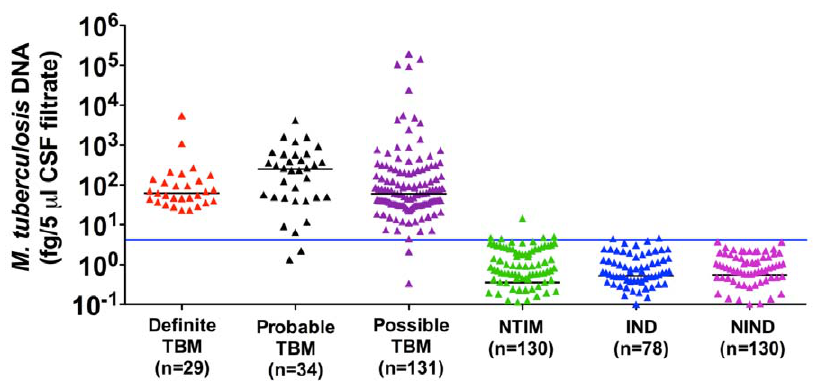
Figure 2. DNA quantitation in CSF filtrates by qPCR. Scatter plot of starting bacterial DNA load (in 5 m l of CSF). The horizontal bar denotes the median value (black line in individual data sets) and the cut-off points (blue line across the plot). The cut-off points were determined by ROC curve